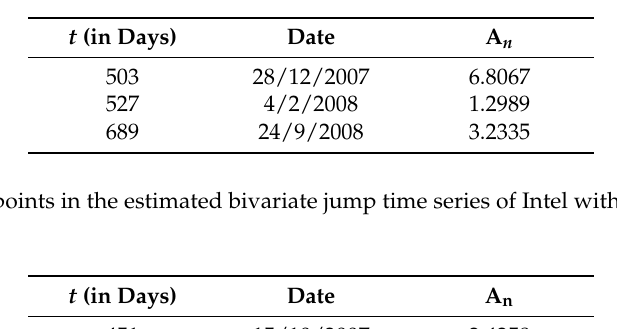
Table 13. Change points for Intel with the corresponding test statistic value.